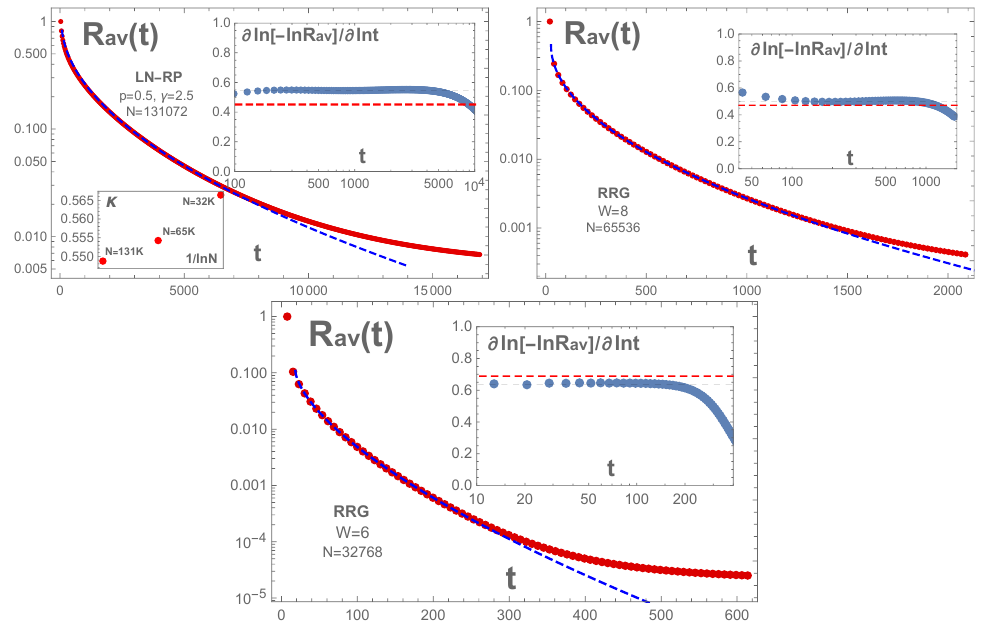
Figure 10: (Color online) (Upper-Left panel): The stretch-exponential behavior of the survival probability for LN-RP ensemble, Eq. (47), in the multifractal phase ( p = 0.5, γ = 2.5 and N = 131072). It was obtained by the numerical Fourier- transform of the “low-energy” part ln ω < − 1.5 of K ( ω ) in the lower-left panel of ( t ) ∼ exp [ − ( tE ) κ ] is qualitatively simi- Fig. 9. The stretch-exponential behavior R av 0 lar to the one obtained in the weakly-ergodic phase of LN-RP model (upper-left panel of Fig. 8), despite the qualitative difference in behavior of µ ( ω ) for ω above the on- set of a shoulder (see left panels of Fig. 9). This demonstrates that only ω below the onset of the shoulder is relevant for the Fourier transform in the time-interval of the stretch-exponential behavior, where the Levy α -stable distribution emerges in K ( ω ) . (Upper-Right panel) : The stretch-exponential behavior of the survival prob- ability for the Anderson model on RRG with W = 8 and N = 65536 in the weakly- ergodic phase obtained by the numerical Fourier transform of the “low-energy” part ln ω < − 1.2 of K ( ω ) shown on the upper-right panel of Fig. 9. For RRG with W = 8 = 0.4728 at the exponent κ ( N = 65536 ) ≈ 0.43 ± 0.05 agrees with the value κ theor N = ∞ obtained from Eq. (36) and the exact F ( g ) (see Appendix B). (Lower panel) : The stretch-exponential behavior of the survival probability for the Anderson model on RRG with W = 6 and N = 32768. The exponent κ ( N = 32768 ) = 0.64 compared = to κ theor